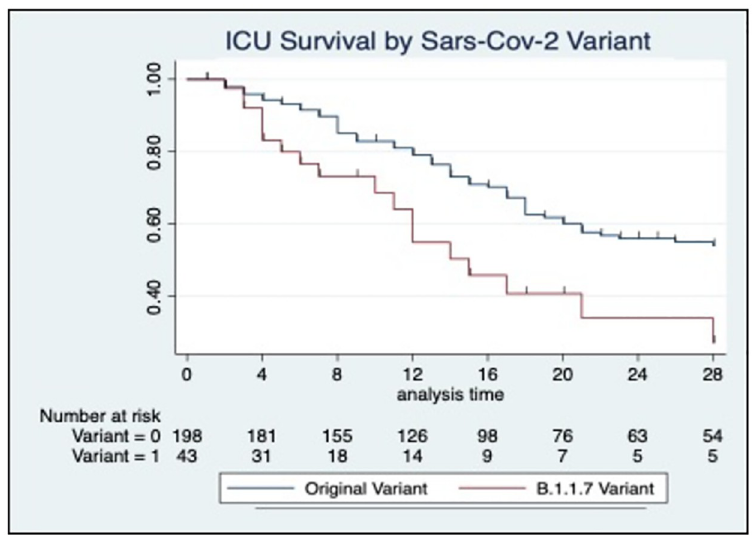
Fig 4. Kaplan-Meier survival demonstrates the proportion of ICU survival by Variant. Log-rank p = 0.004 demonstrating that those patients with variant B.1.1.7 have a significant less chance of survival compared to